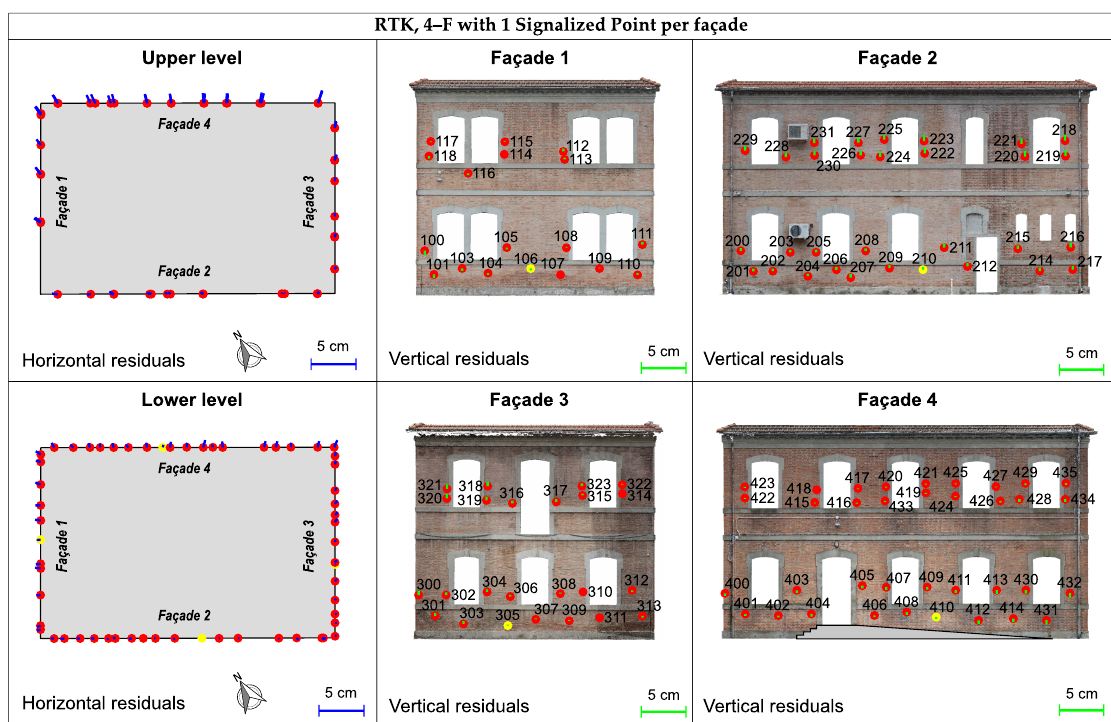
Figure A7. Horizontal and vertical residuals for RTK image dataset processed as an overall block (4–F) with the introduction of one SP per façade (used as a GCP and shown in